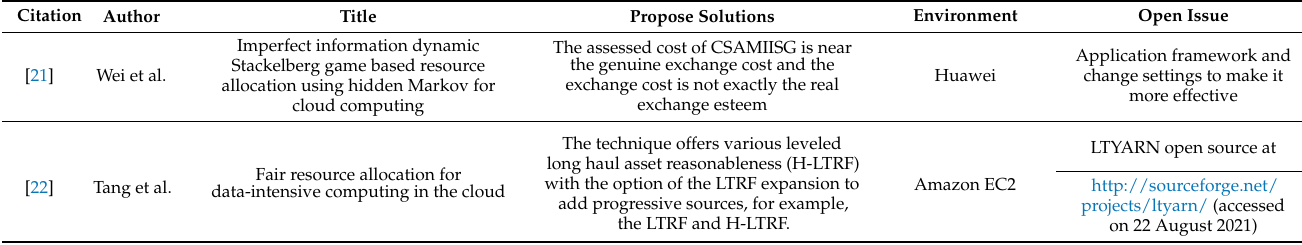
Table 1. Summary of Related Works on Resource allocation in Cloud computing and their pro- posed